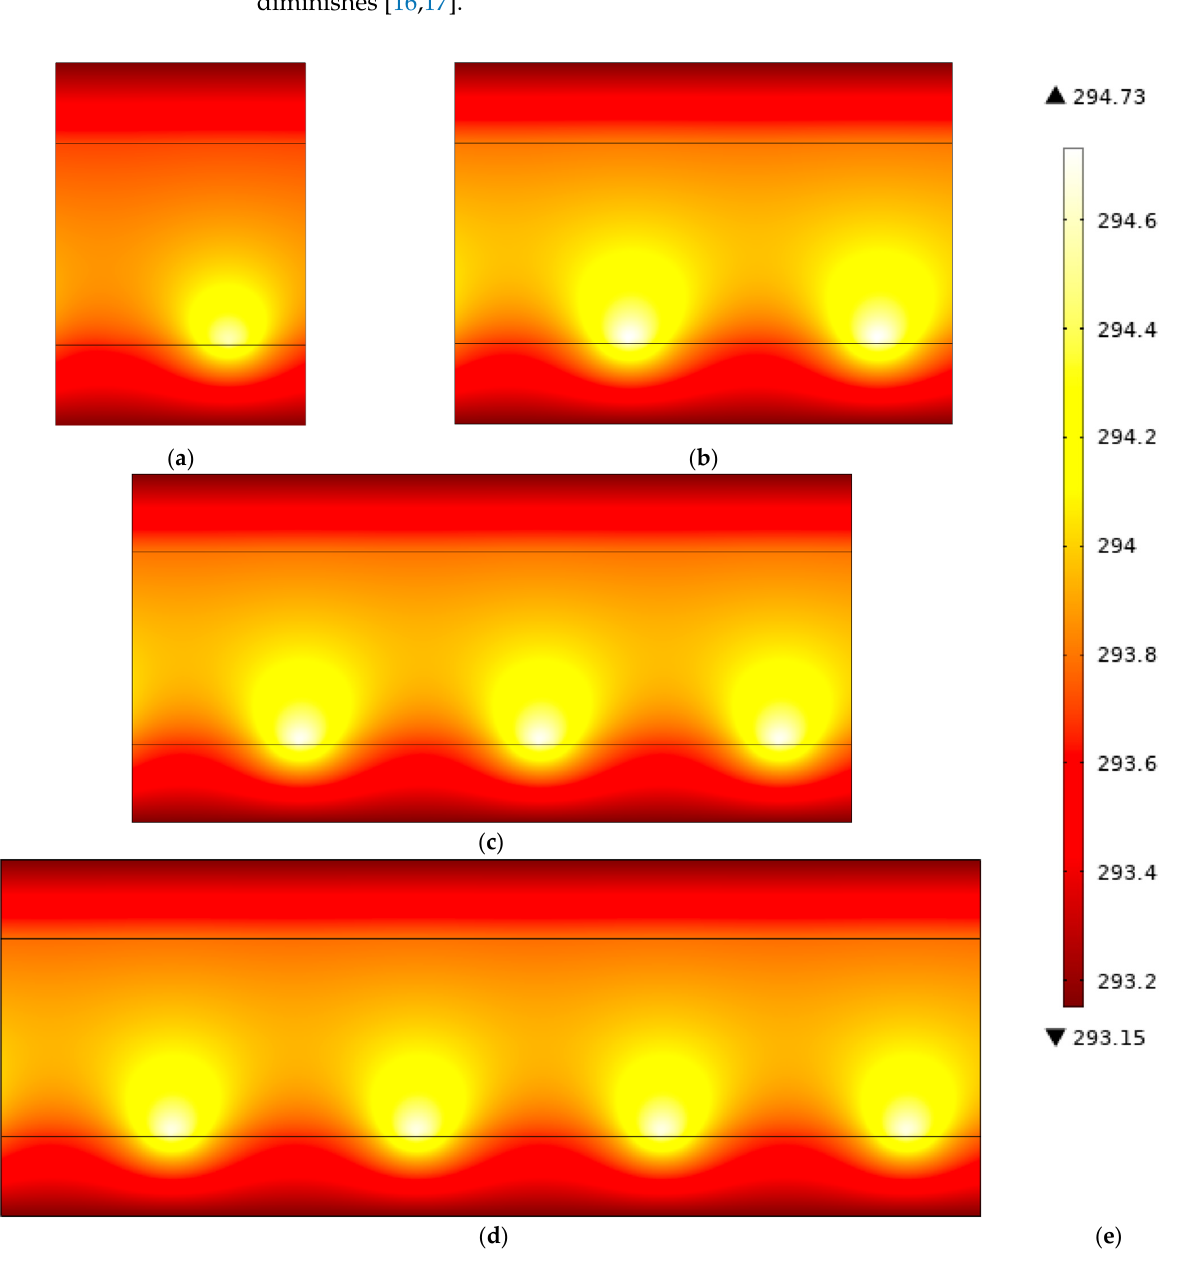
Figure 4. The temperature in an ACET channel, where black lines indicate the fluid-glass boundary, given for ( a ) 1-phase, ( b ) 2-phase (180° phase separation), ( c ) 3-phase (120° phase separation) and ( d ) 4-phase (90° phase separation) con fi gurations at 5 V peak , where the far-left electrode is set to a phase angle of 0°. ( e ) shows the color legend for the temperature pro fi les.